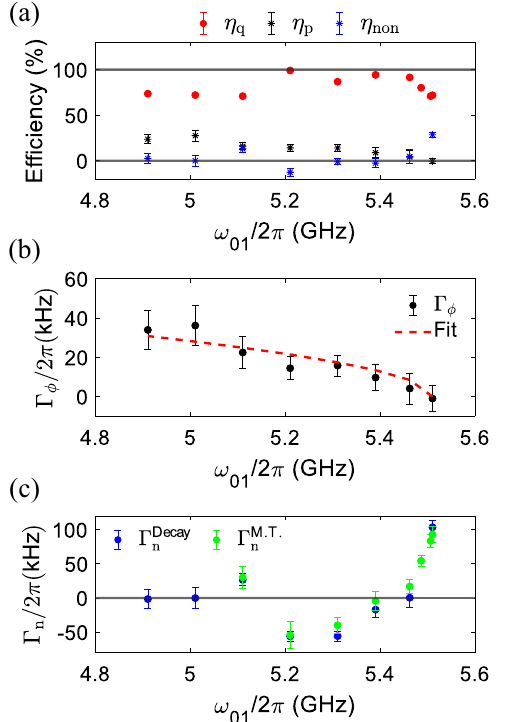
Fig. 4 Intrinsic quantum ef fi ciency, pure dephasing and non- radiative decay rates as a function of the qubit frequency. a The intrinsic quantum ef fi ciency η q for our single-photon source over the 600 MHz tunable range. The ef fi ciency is limited by the pure dephasing rate and the non-radiative decay rate of the qubit. These two factors reduce the ef fi ciency by η p and η n respectively, where we have η q + η p + η n = 1. b Pure dephasing rate Γ ϕ as a function of the qubit frequency. c Nonradiative decay rate Γ n as a function of ¼ Γ Decay (cid:2) Γ the qubit frequency, where we have Γ Decay r and 1 n Γ M : T : are extracted from the exponential n decay of the qubit power emission and the off-resonant Mollow- triplet spectrum from the qubit fl uorescence, respectively. The value of Γ r is from the re fl ection coef fi cient measurement. In all panels, the error bars are two standard